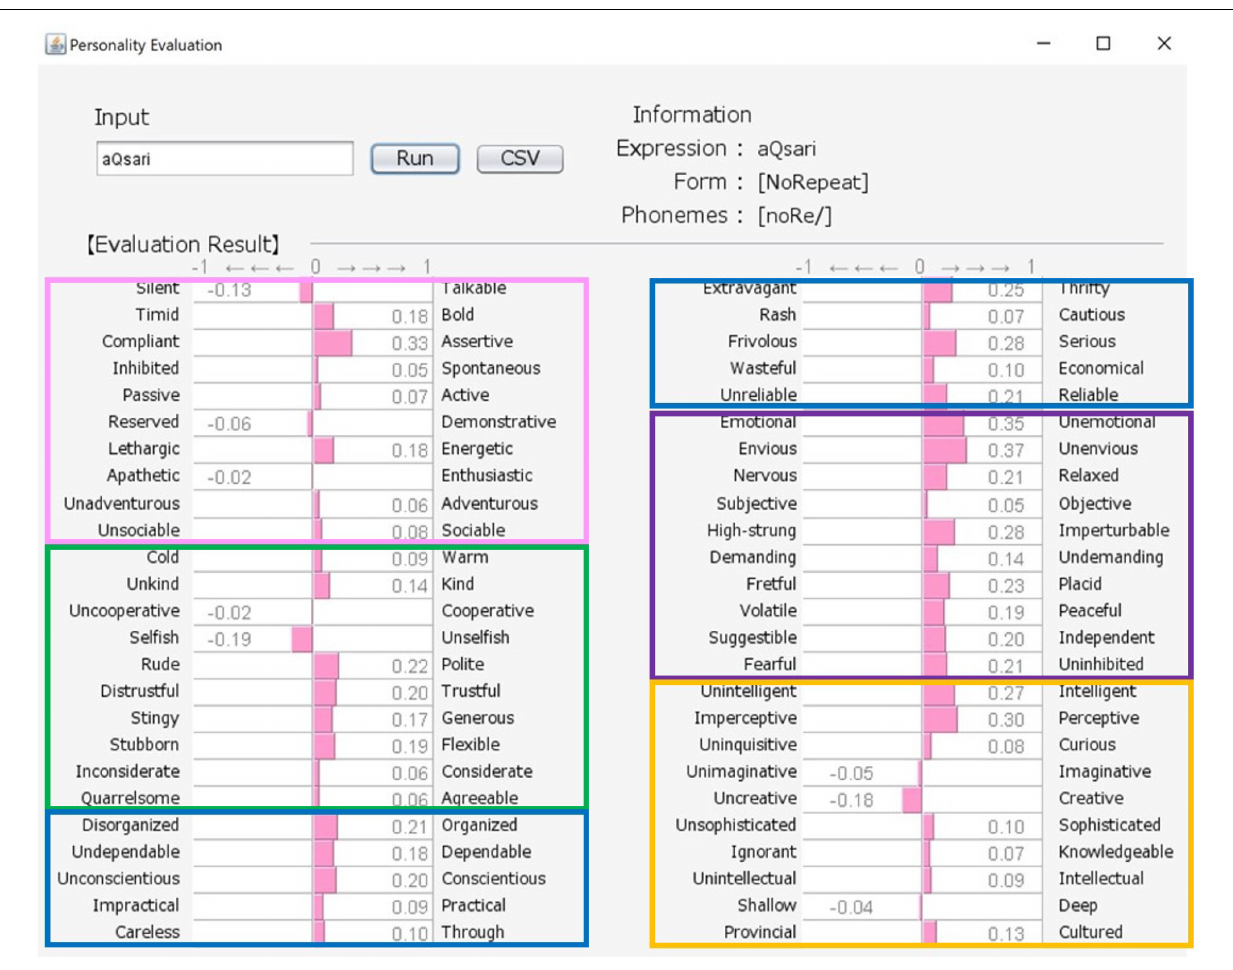
Frontiers in Psychology |